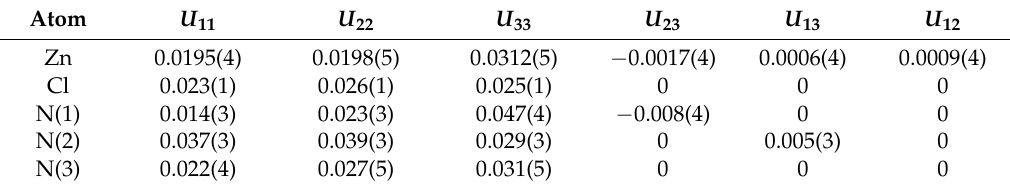
Table A1. Anisotropic displacement parameters U ij (10 4 pm 2 ) for [Zn 2 (NH 3 ) 2 (NH 2 ) 3 ]Cl.